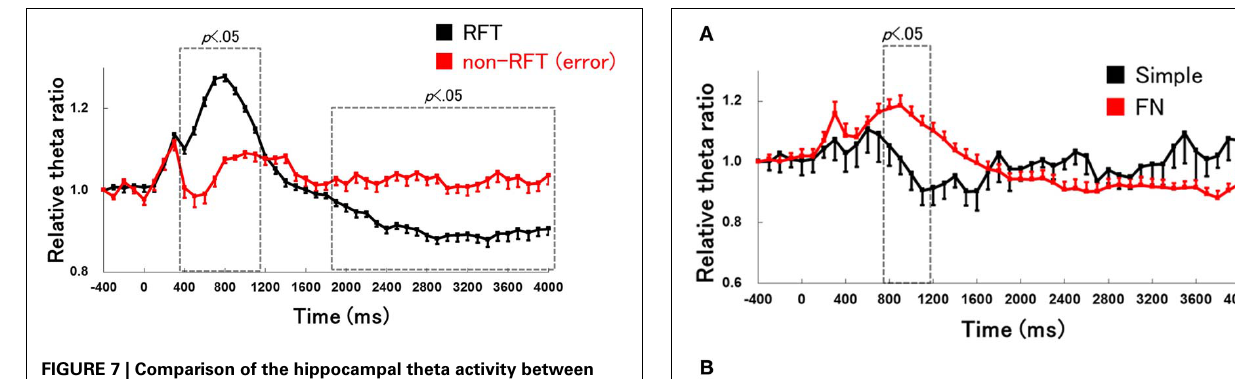
FIGURE 7 | Comparison of the hippocampal theta activity between correct lever press responses for RFTs (RFT) and incorrect lever press responses for non-RFTs [non-RFT(error)] on the late learning stage of the FN task. The 0-ms period indicates the onset of stimulus presentation. The period was divided into 45 sub-periods of 100ms each. The mean hippocampal theta power from 500 to 400ms before the stimulus onset was counted as the − 400-ms period (no stimuli were present and no rats pressed the lever during this period), and the relative theta power calculated for each period was normalized to that of the − 400-ms period (relative theta power of each period = theta power of each period/theta power at the − 400-ms period). The hippocampal theta power increased in 400- to 1100-ms epochs and decreased at 1900–4000ms periods during the correct lever press responses for RFTs compared with during incorrect lever press responses for non-RFTs in the late learning stage of the FN task (all p < 0 . 05 ). Error bars indicate s.e.m. FIGURE 8 | The change in hippocampal theta power during the RFTs